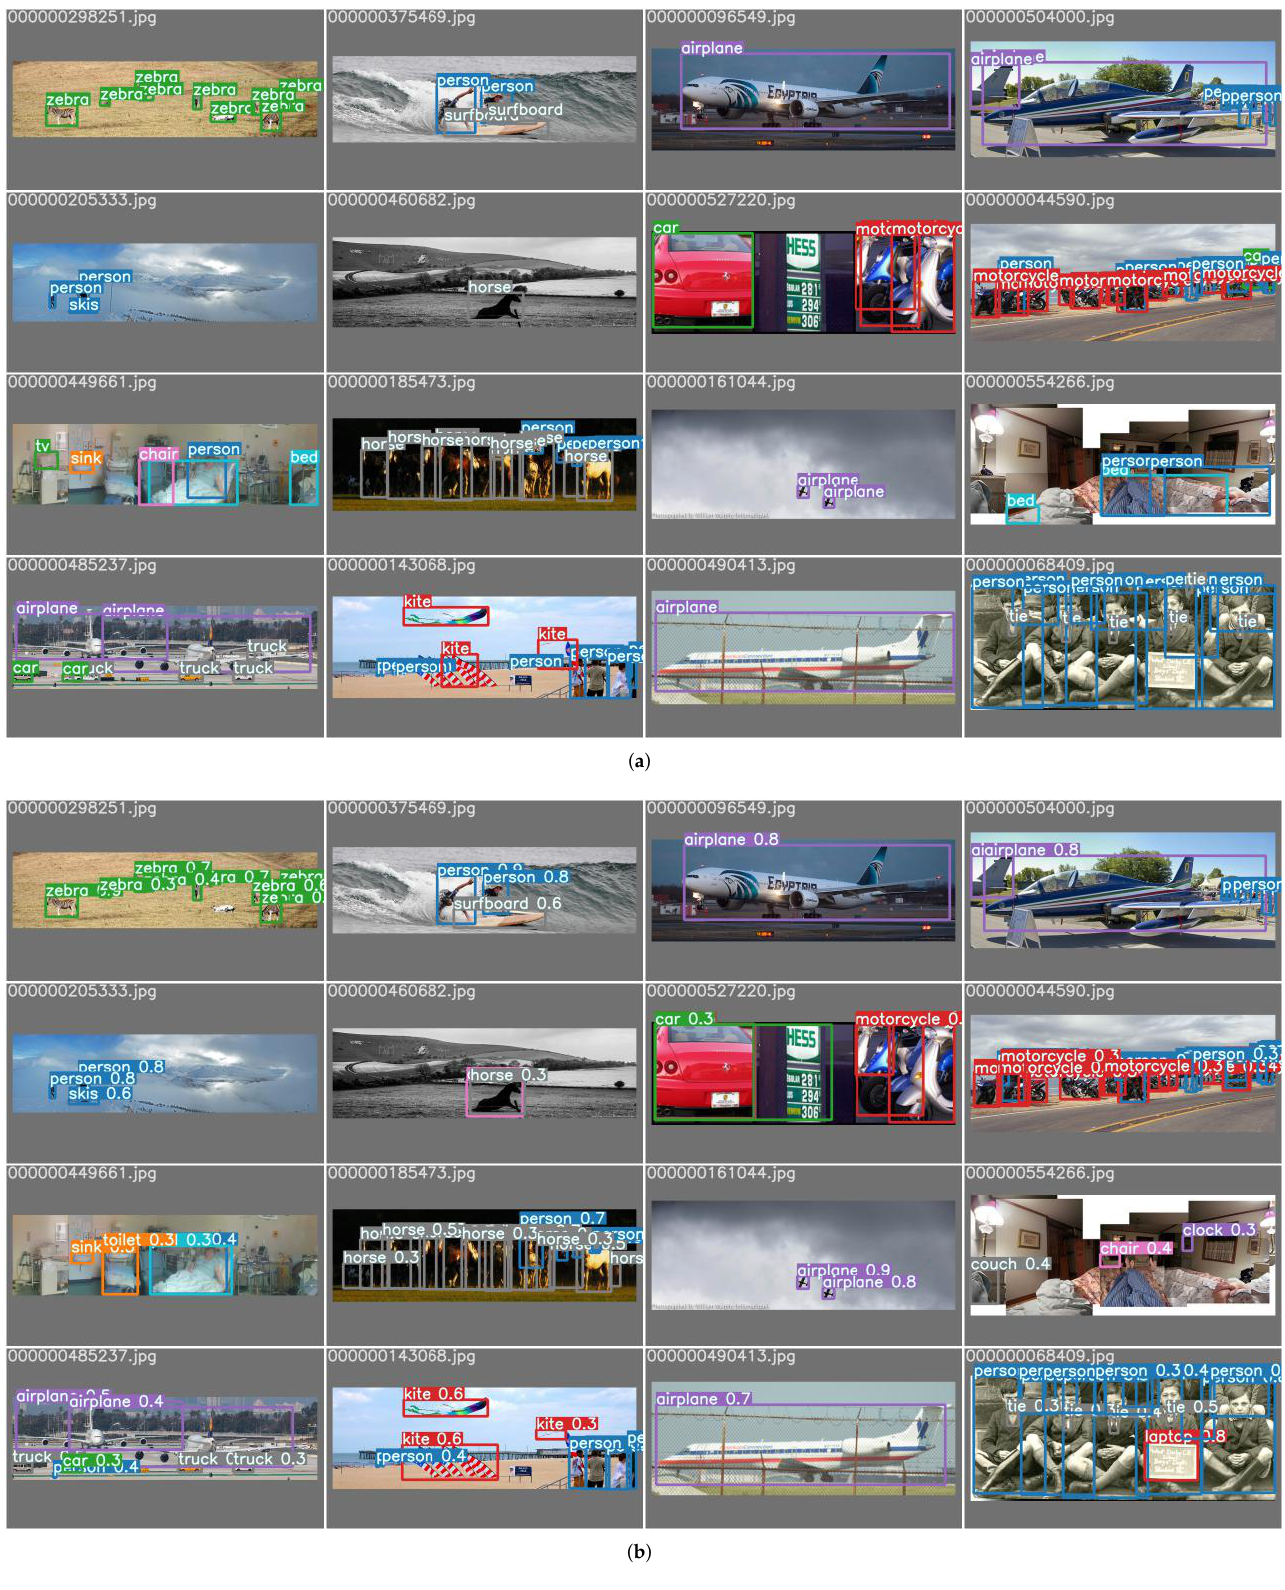
Figure 8. Ground true ( a ) and predicted ( b ) bounding boxes of images from the validation set of COCO. Different colors in each images denotes different categories. ( a ) Ground Truth; ( b )